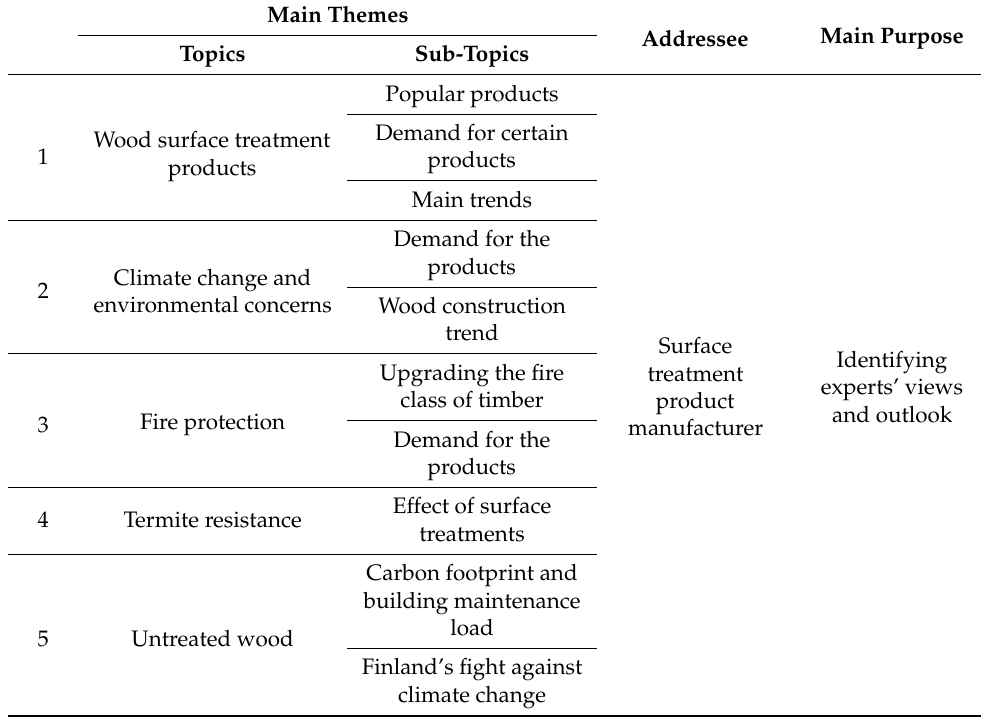
Table 3. The main themes, addressee, and main purpose of the interview questions (Appendix